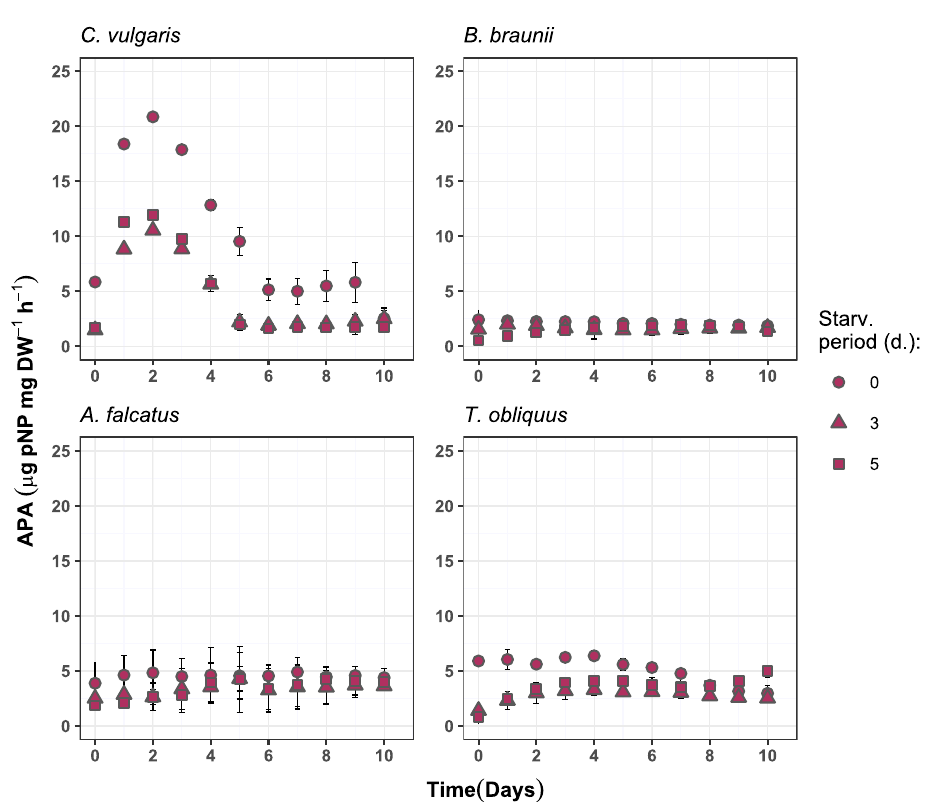
Figure 6. Alkaline phosphatase activity change over time in the experiment batches for C. vulgaris, B. braunii, A. falcatus, and T. obliquus (means ± SD, n = 3).